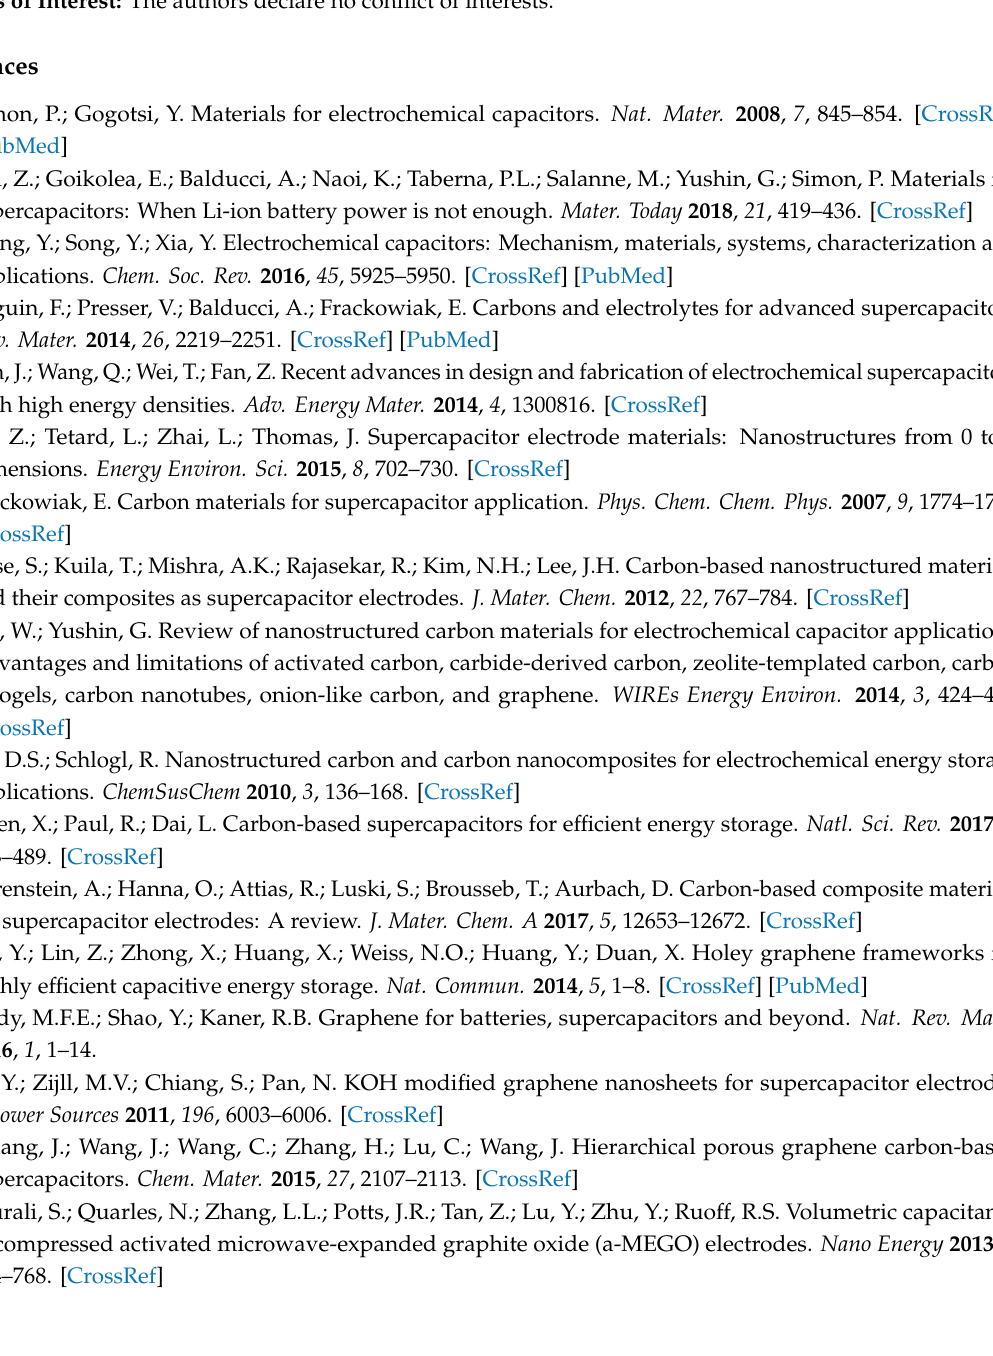
Table S2- Thickness and film density values of various HGNS electrodes. Table S3- Gravimmetric capacitance of AC, HGNS-900 and various AC / HGNS-900 electrodes. Table S4- Performance comparison of previously reported AC / graphene composite electrodes and AC / HGNS-900 (20:1). Table S5- Electrolyte resistance (Rs) and interface contact resistance (Rinter.) values of various cells. Figure S1- TEM micrographs of HGNS samples. Figure S2- XPS C1 s spectra of HGNS-900 sample, Figure S3- Galvanostatic charge–discharge curves of AC and various AC / HGNS-900 cells measured at various current densities. Figure S4- Ragone Plots of various